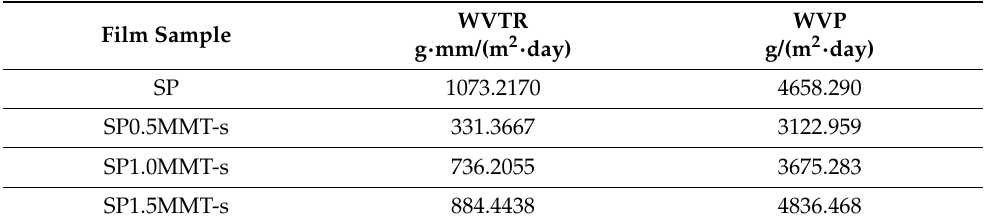
Table 3. Water vapor transmission rate (WVTR) and water vapor permeability (WVP) of starch- polyvinyl alcohol (SP) film reinforced with nanoclays (MMT), sonicated with